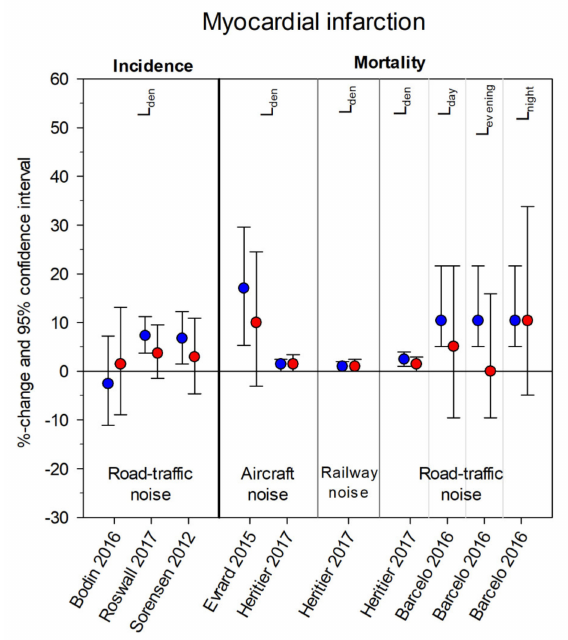
Figure 6. Sex/gender-specific effect estimates from studies with the cardiovascular outcome myocar- dial infarction. Effect estimates are displayed as percent changes (blue = males, red = females) and 95% confidence intervals per 5 dB(A) increase in noise exposure (aircraft noise, railway noise, road traffic noise) and grouped according to frequency measure (incidence, mortality) and noise indicator (L den , L day , L evening , L night ). Please note, some studies provided several estimates for different noise indicators per noise exposure and frequency